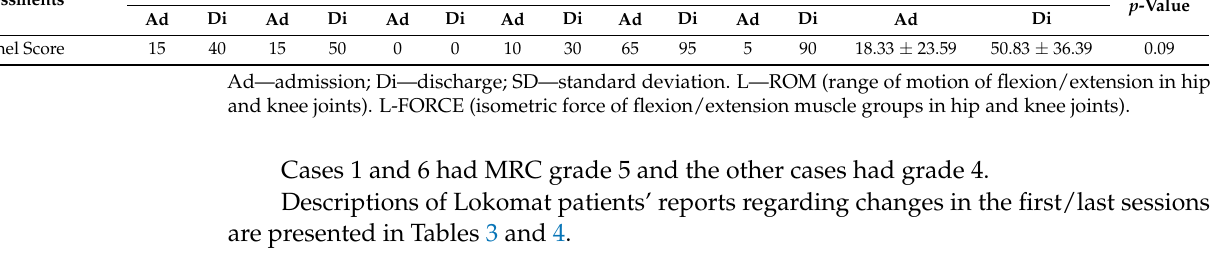
Table 4. Lokomat assessment: changes in the first/last